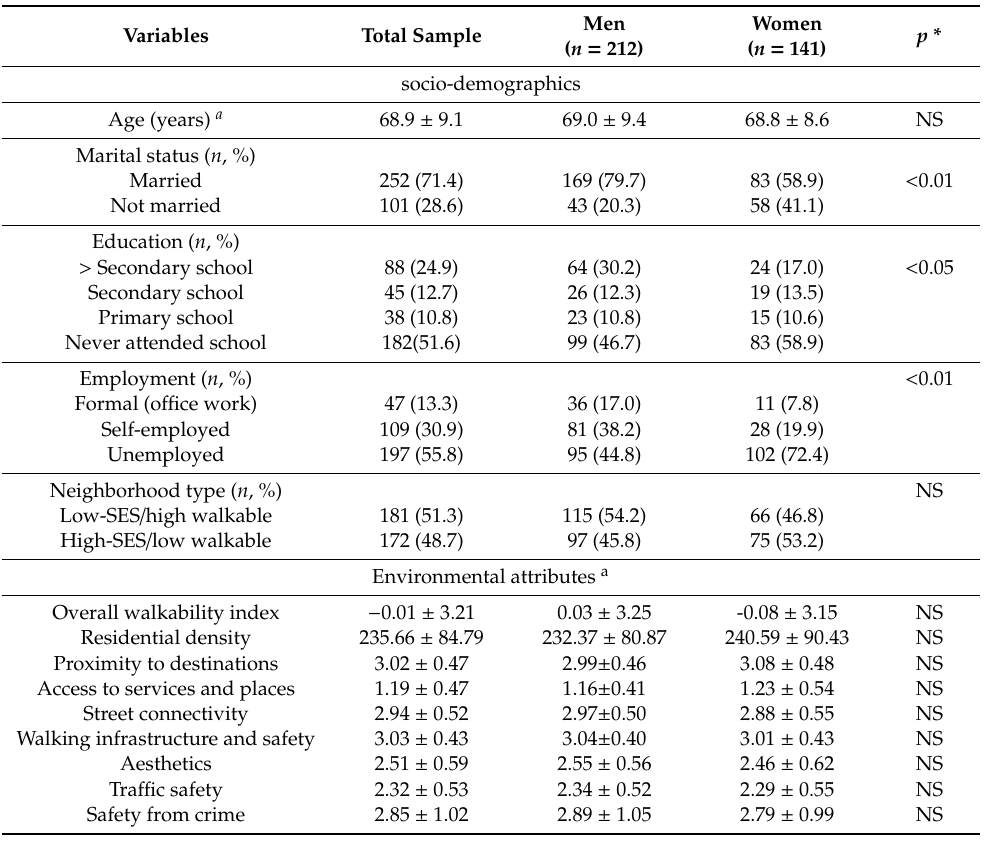
Table 1. Participants’ sociodemographic characteristics and descriptive information of neighborhood environmental attributes and sedentary time ( n =